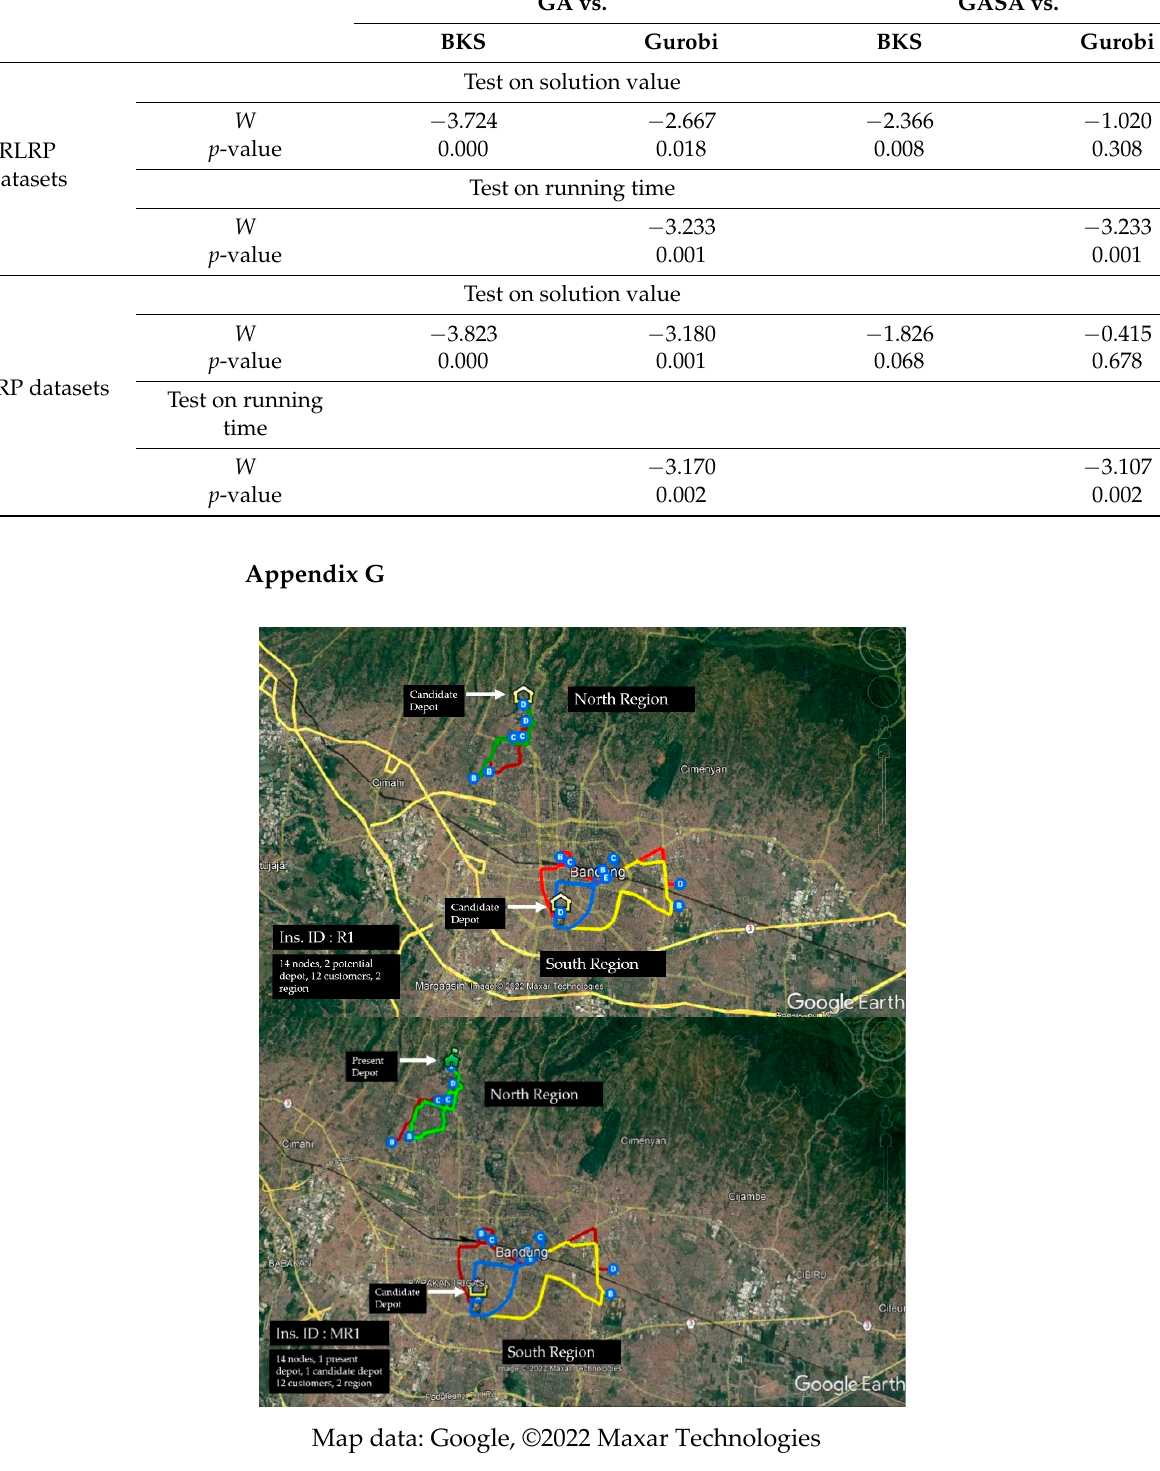
Figure A3. The sample illustration for RLRP and MRLRP solutions on Google Earth.